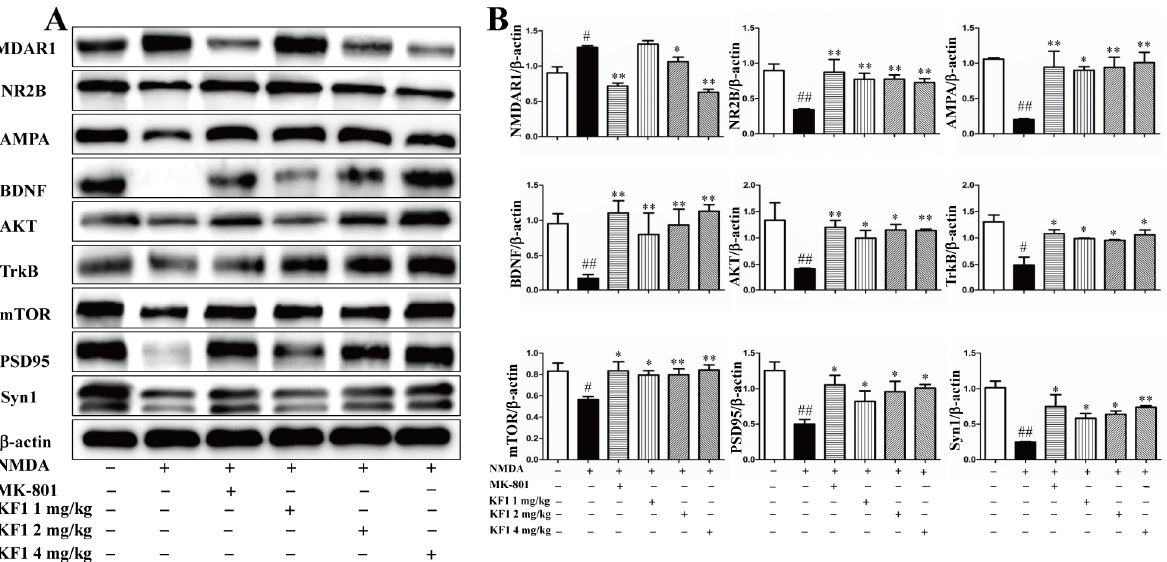
Figure 9. Effect of KF1 on the expression of related proteins in hippocampus. ( A ) Interacting protein expression in hippocampus; ( B ) quantitation of interacting protein levels in hippocampus. The relative optical density was normalized to β -actin. The data are expressed as means ± SEM ( n = 3). # p < 0.05, ## p < 0.01 versus vehicle group; * p < 0.05, ** p < 0.01 versus NMDA group.